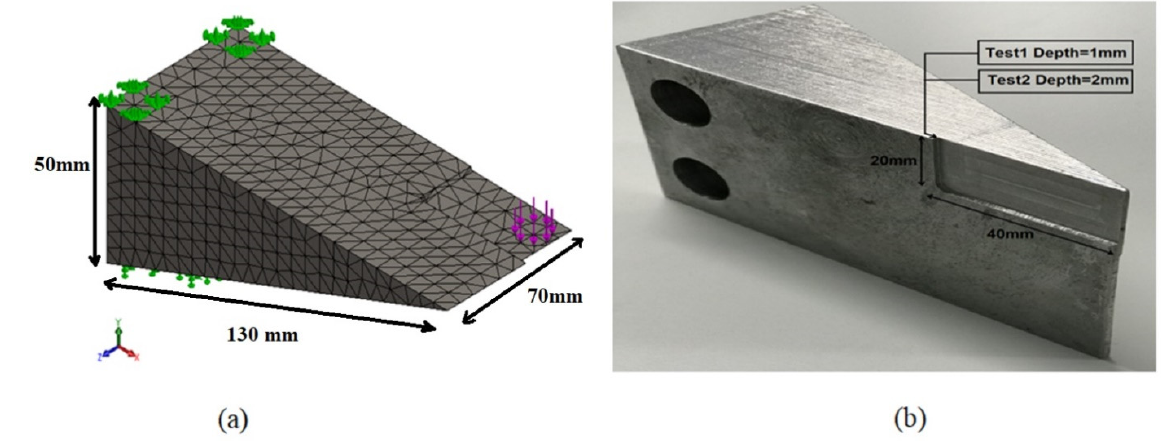
Figure 4. ( a ) The 3D drawing schematic used for the simulation study and ( b ) the actual test set-up representing the cut for simulating the wear and used for the experimental strain measurement tests. The two holes are needed to fix the metallic part; all parts are bolted to a large steel bed secured to heavy steel support.